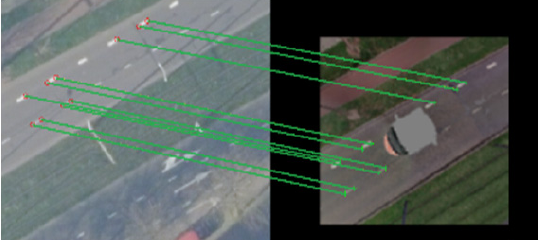
Figure 16 Förstner Cross-Correlation matching result of 12 th tile